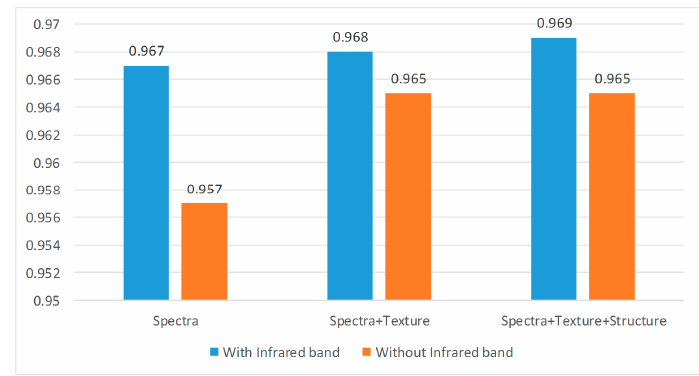
Figure 12. Average OA of 172 Landsat ETM+ images with different feature combination.